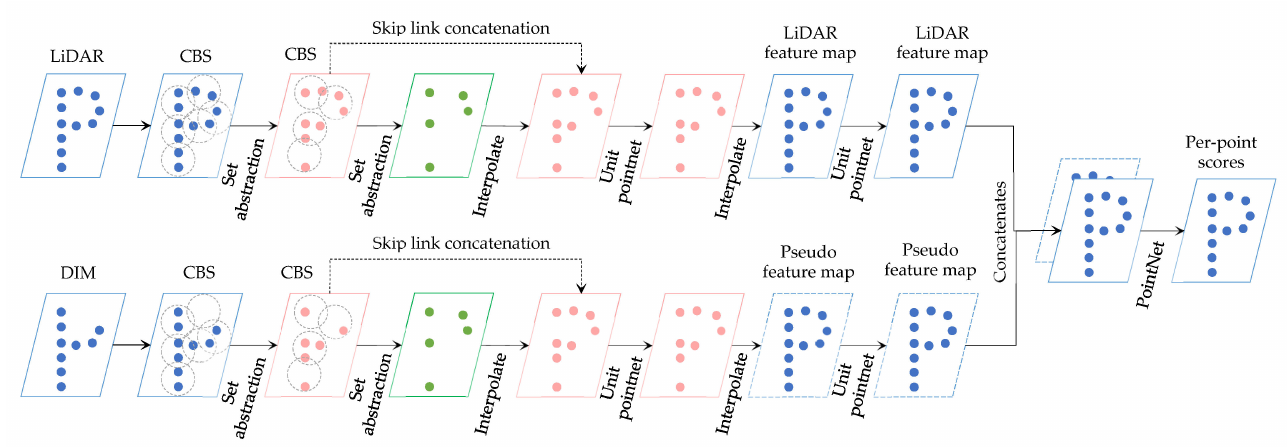
Figure 11. SiamPointNet++ network architecture